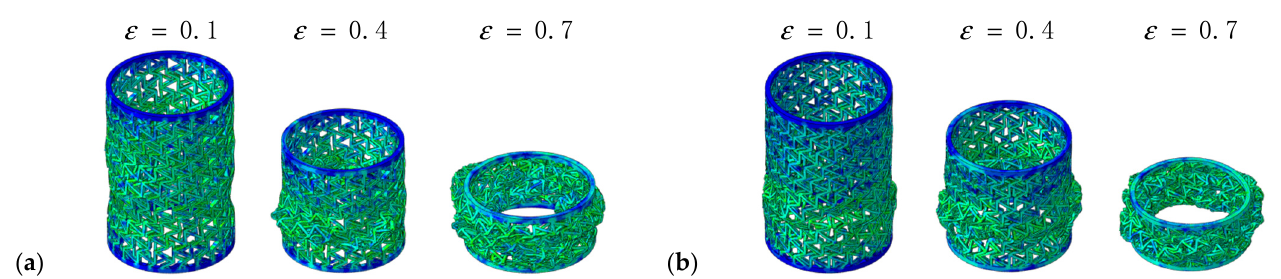
Figure 23. The deformation modes of multi-layer composite RHCSs under low velocity: ( a ) [30°/ − 30°/30°] RHCS; ( b ) [30°/ − 30°/30°/ − 30°] RHCS.